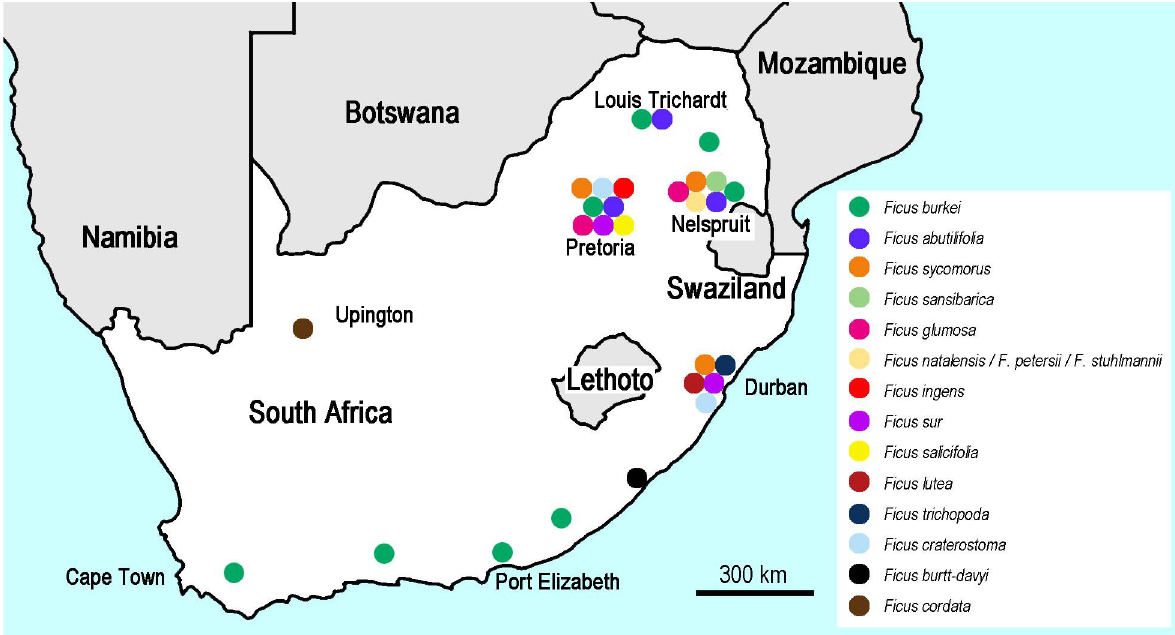
Fig 1. Map of southern Africa, country names in large font, city names in small font. Each color dot represents a fig species sampled in the area, mostly associated with cities. The color legend defines the fig species that each color represents.